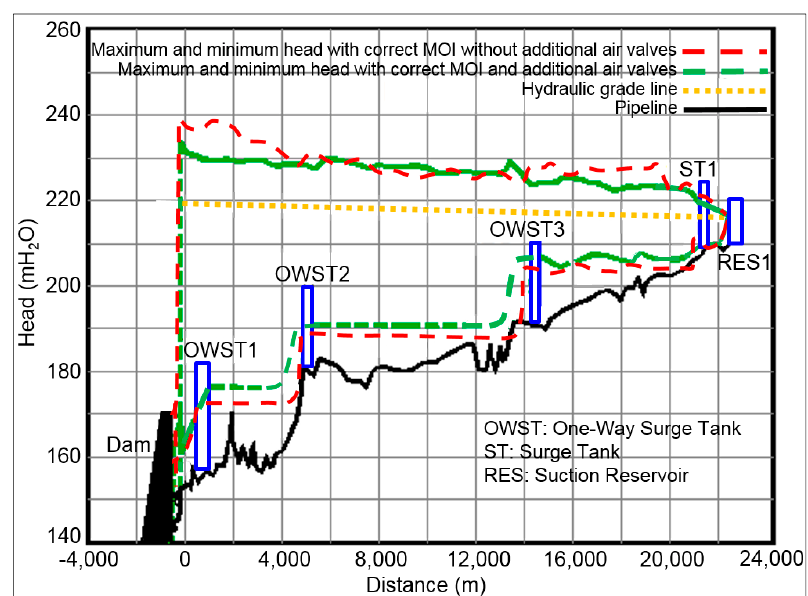
Figure 8. Maximum and minimum head envelopes for the first pipeline segment with and without additional air valves and the correct moment of inertia (MOI), following the simultaneous power failure of the two pumps at Pumping Plant 1.